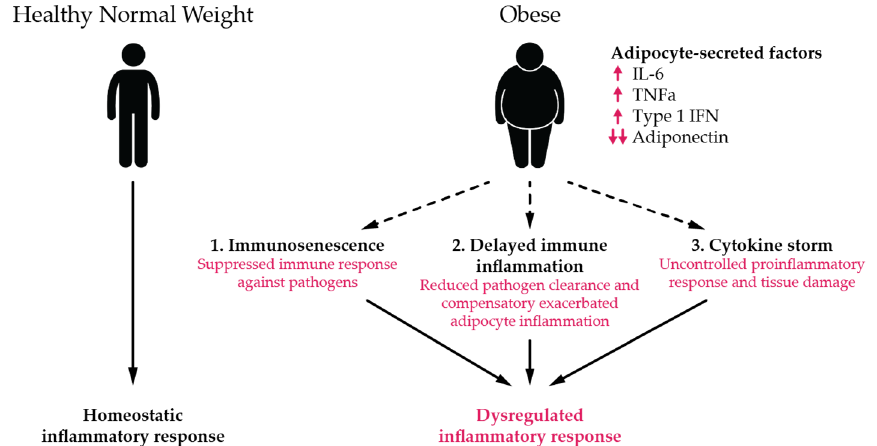
Figure 6. Role of obesity in inflammatory response to infection. Adipocyte-secreted factors (e.g., adiponectin, leptin, Type I IFNs, and IL-6) contribute to normal homeostatic immune responses against infectious pathogens among healthy/normal weight. Obesity-dependent changes in adipo- cyte function can contribute to (1) immunosenescence (suppressed immune response against path- ogens); (2) delayed immune inflammation (reduced pathogen clearance and compensatory exacer- bated adipocyte inflammation); and (3) “cytokine storm” (IL-). Modified from Alarcon, 2021 [29].